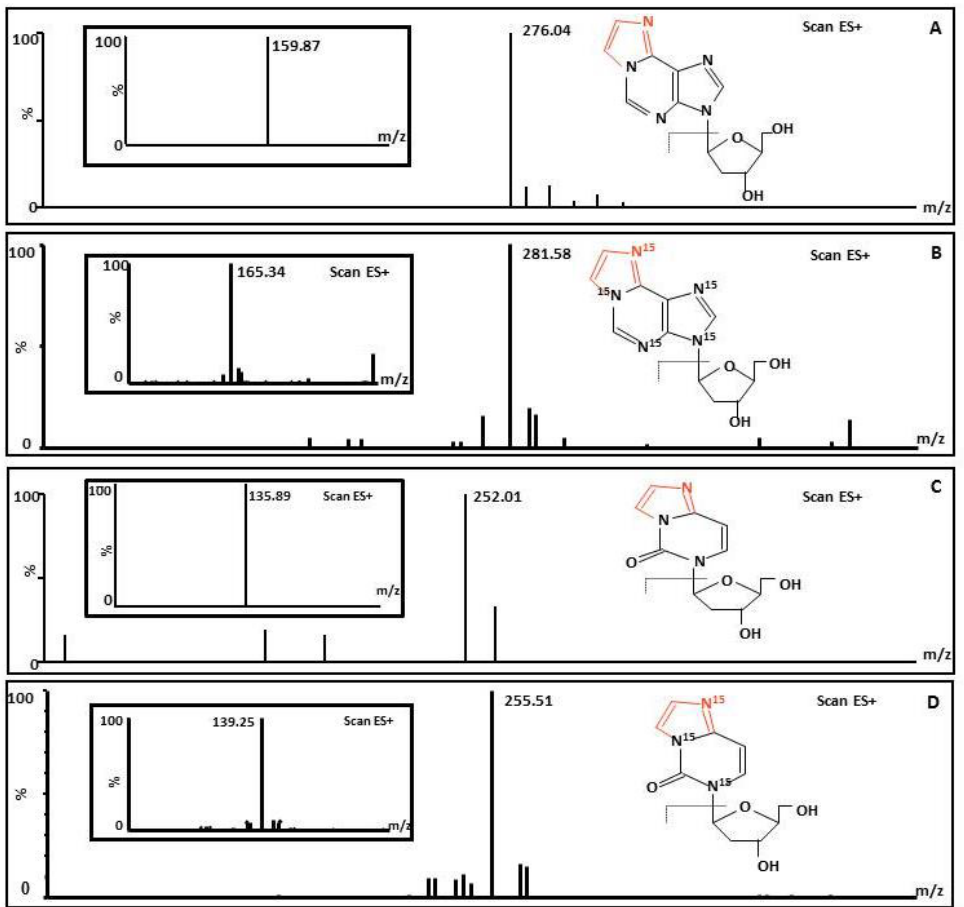
Figure 1. Structures and mass spectra of the 1, N 6 -etheno-2’-deoxyadenosine and 3, N 4 - etheno-2’-deoxycytidine standards and [ 15 N 5 ]-1, N 6 -etheno-2’-deoxyadenosine and [ 15 N 3 ]- 3, N 4 -etheno-2’-deoxycytidine as internal standards (I.S.). ( A )  dA; ( B ) [ 15 N 5 ]  dA; ( C )  dC; ( D ) [ 15 N 3 ] 